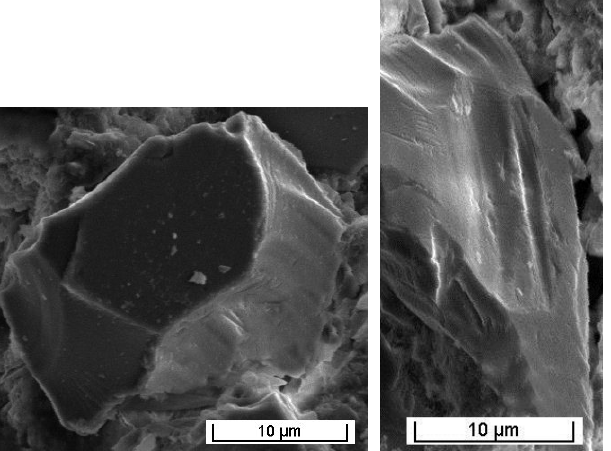
Figure 6. Views of a glass particle (MEB in secondary electrons).